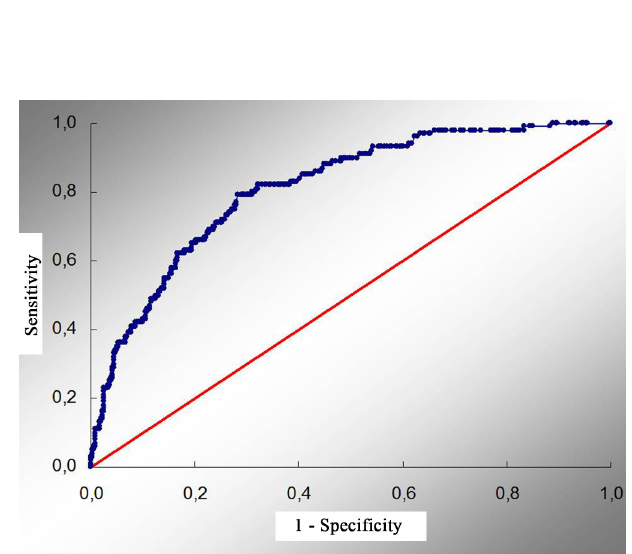
patientsFig. 1 - ROC curve for InsCor 0.79 [95% CI (0.74 to 0.83), P<0.001] and the EuroSCORE was 0.81 [95% CI (0.77 to 0.86), P<0.001] in the evaluation of the power of discrimination performed in 1,000